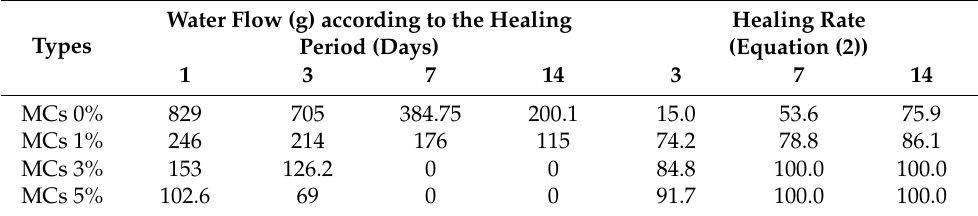
Table 6. Healing performance according to